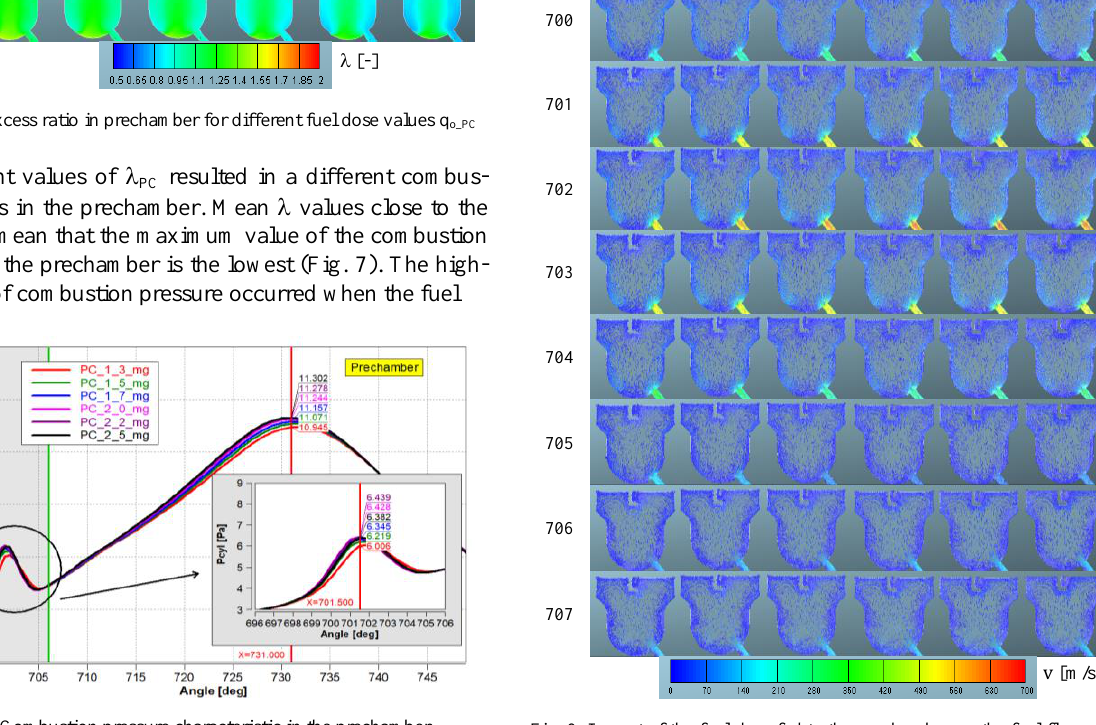
Fig. 9. Impact of the fuel dose fed to the prechamber on the fuel flow rate value between the prechamber and the main